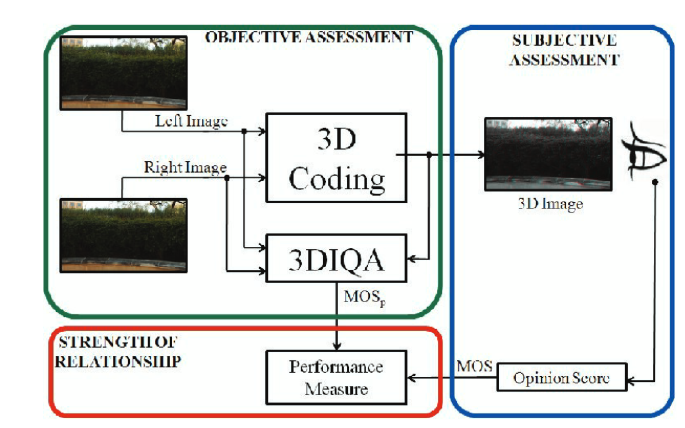
Figure 8. Methodology for Stereoscopic Image Quality Assessment.